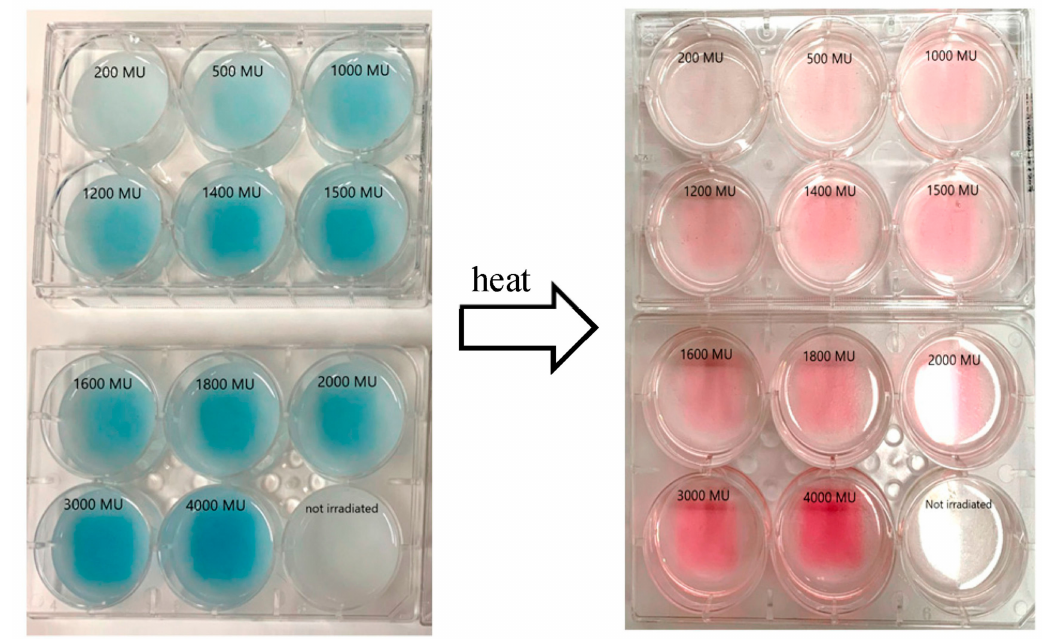
Figure 3. PDA-RTV gel. ( Left ): Each well was irradiated with a 6 MV beam by different monitor unit doses; ( right ): the sample after heating and curing the gel to obtain transparency.